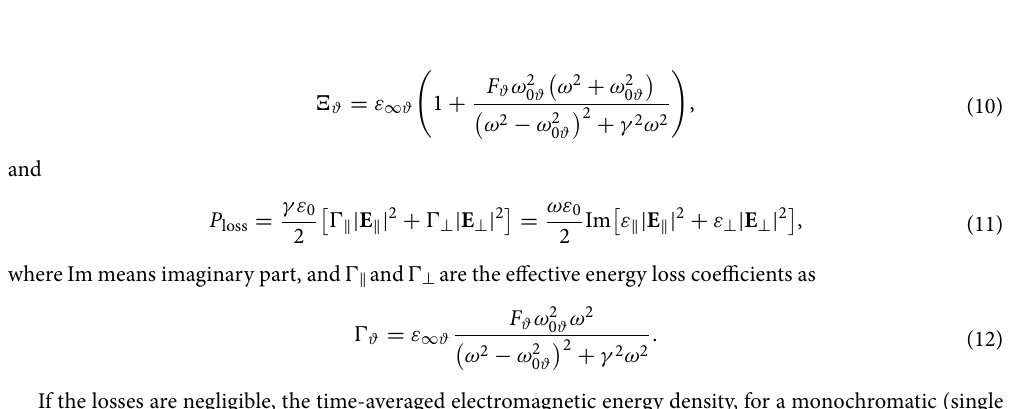
Figure 1. ( a ) Schematic of a periodic array of metallic nanowires embedded in a host dielectric matrix, as a typical 2D geometry of HMMs. The host matrix is not shown. This array of nanowires aligned with the z -axis and arranged on a square lattice in the xy -plane. ( b ) A nanowire HMM is an effective medium that has different dynamical properties in the direction parallel and perpendicular to its optical axis (the z